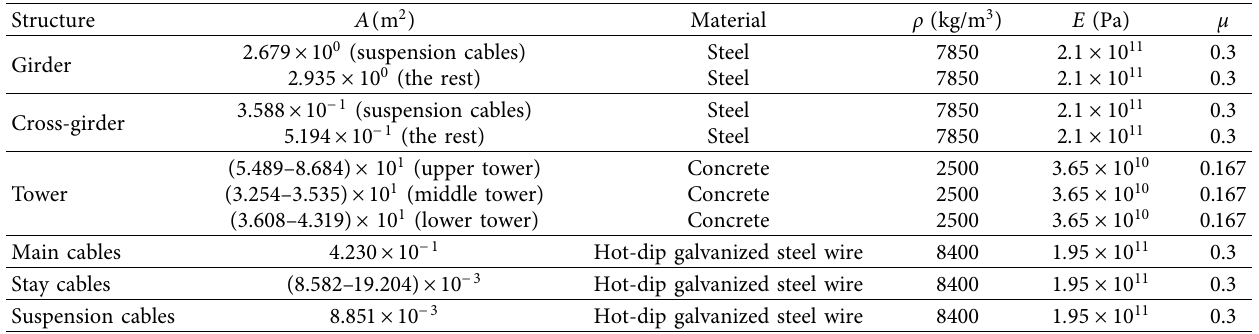
Table 1: Material properties.